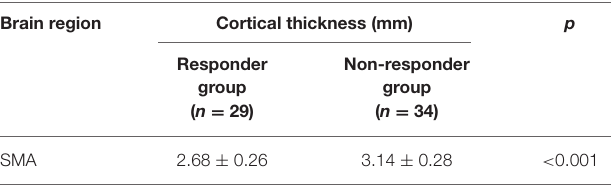
TABLE 5 | Cortical thickness of SMA in the right hemisphere of the responder and non-responder groups at baseline.